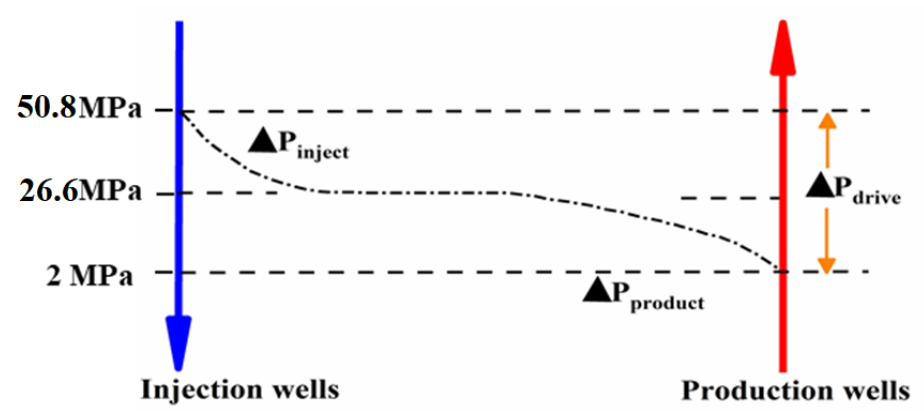
Figure 14. Schematic diagram of pressure changes between injection and production wells.